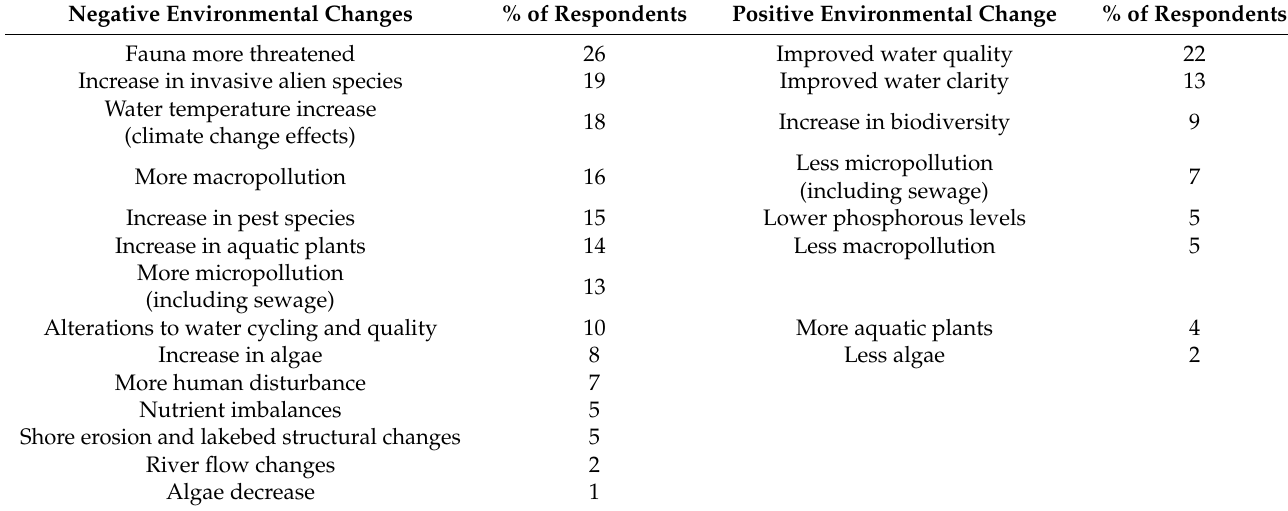
Table 1. An overview of the negative and positive environmental changes listed by respondents. Note that percentages add up to more/less than 100 as many respondents mentioned more than/less than one negative or positive change. Only the responses from the semi-structured questionnaires were included in